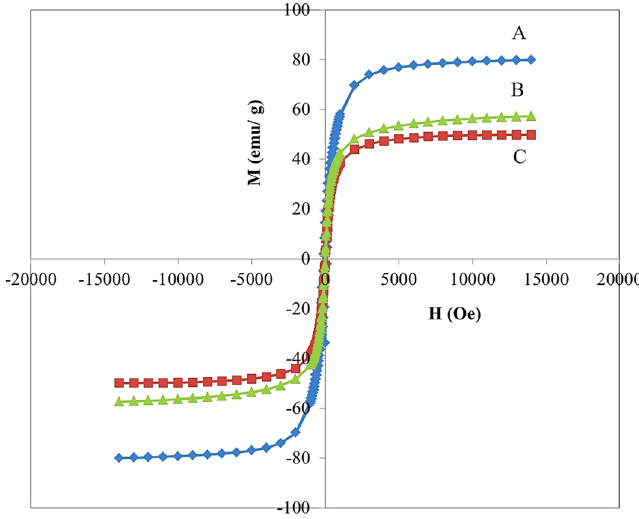
Figure 4. Magnetization curves of ( A ) iron oxide nanoparticles; ( B ) core–shell nanoparticles (FPEGSO- MLDH); ( C ) core–shell nanoparticles (FPVASO-MLDH). Notes: The data is presented in terms of Ms, mass magnetization (emu/g) versus H, applied magnetic field (Oe).